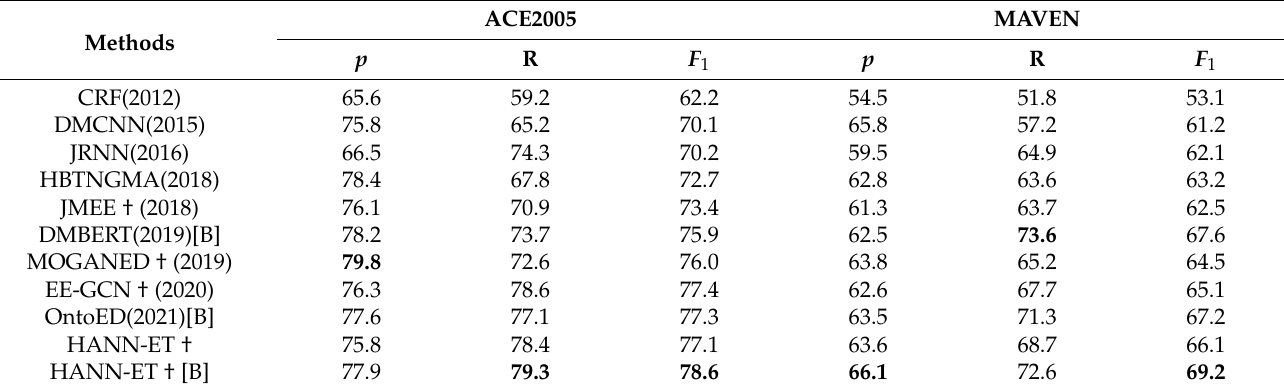
Table 4. Overall performance on two datasets in the case of cross-validation